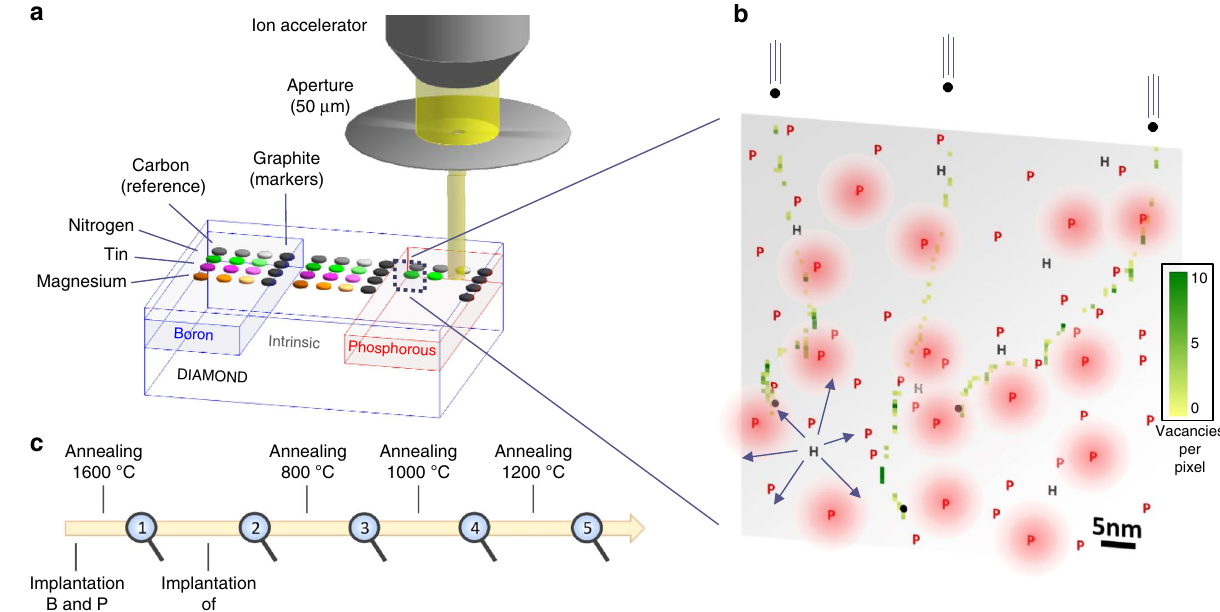
Fig. 1 Colour centre implantation within three doped regions. a Scheme of the diamond sample (quantum grade from Element 6) prepared with intrinsic, p- type and n-type areas (using boron and phosphorous implantation with [P] and [B] ̴ 3 × 10 18 cm − 3 , see supplementary information) and implanted with a series of different chemical elements: carbon (as reference) and nitrogen, tin, and magnesium to produce, NV, SnV and MgV centres. The depth of the centres (~ 50 nm) is controlled by the implantation energy and fi ts with the dopant depth pro fi les (see supplementary information). b Illustration of the sample status after implantation in the Phosphorous-doped region, as represented by a 60 × 60 nm² cross-section. The implantation-induced vacancies are simulated by SRIM. The density is given in number of vacancies per pixel of size 0.6 × 0.6 nm². The phosphorous atoms are represented by the red P letters, with inter-distance corresponding to [P] ≈ 3 × 10 18 cm − 3 . The red halos represent substitutional P active donors which are non-passivated and non- self-compensated. Hydrogen atoms are also represented at a density of 1 × 10 17 cm − 3 , with arrows accounting for their large diffusion (~ 6 × 10 7 nm² s − 1 at 800 °C in IIa diamond 34 ). Less than 2.5 nitrogen and 0.5 boron atoms are expected within this section for native concentration [N] < 5 ppb and [B] < 1 ppb. NVH, V 2 , V x , VH, and PV are the main competing defects to NV formation, whereas PH may passivate the donors. NVN forms at much